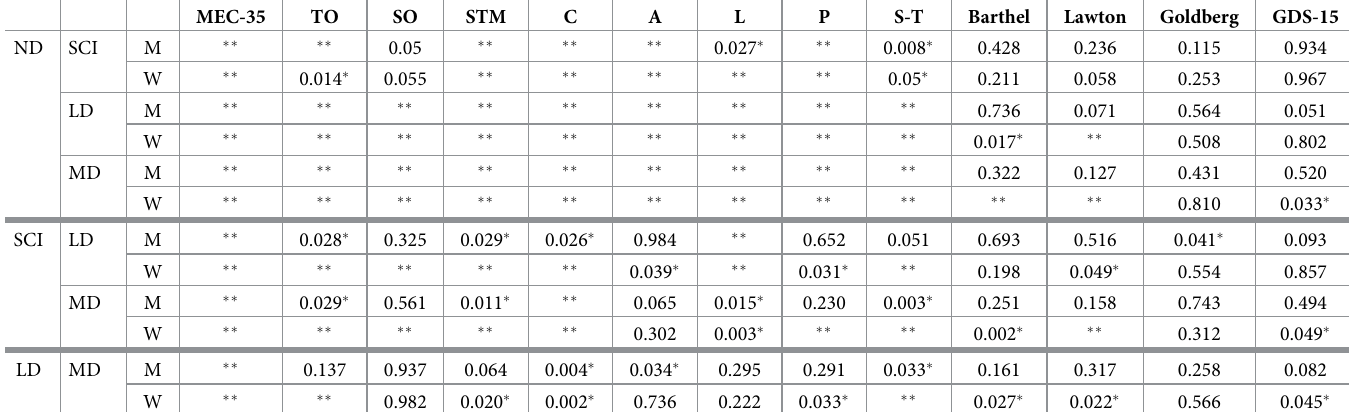
Table 3a 2 . By levels and gender, the p-value of the mean differences test between the quantitative variables. MEC-35 TO